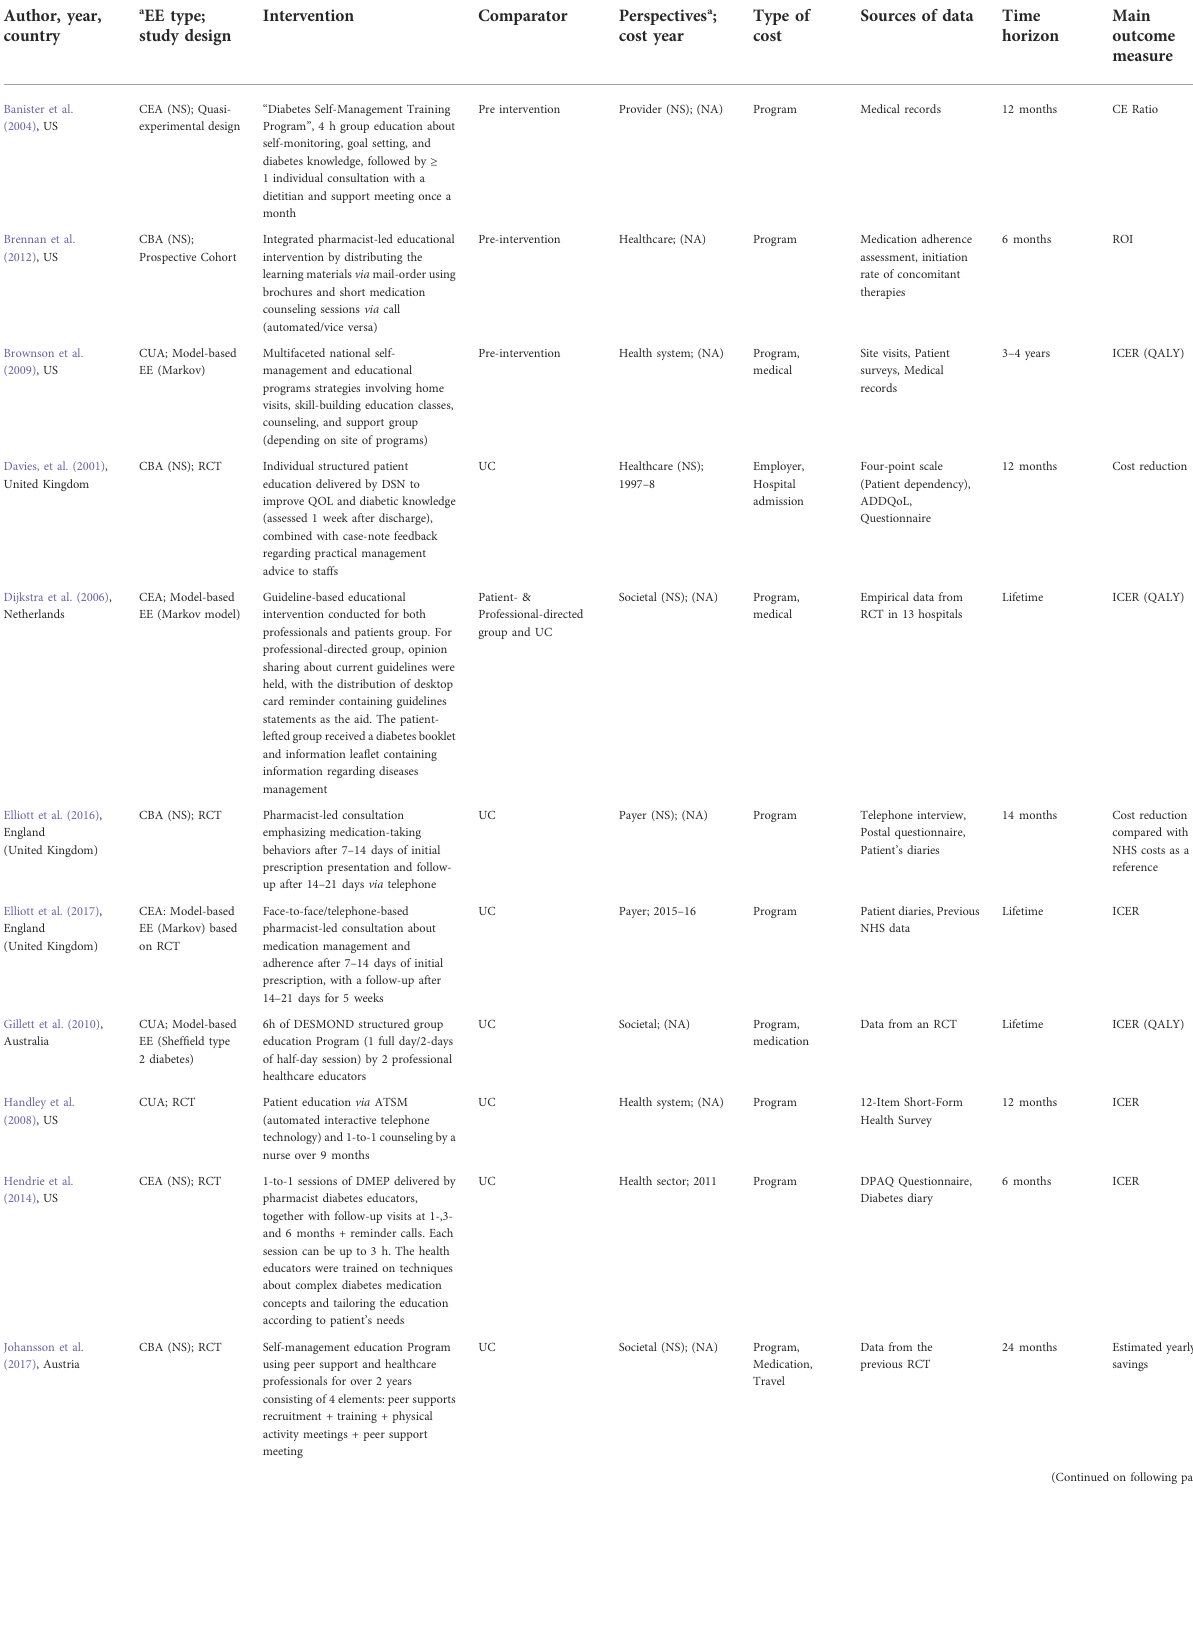
TABLE 1 Study characteristics of a systematic review of the cost-effectiveness of different types of educational interventions in type II diabetes mellitus. Author, year,